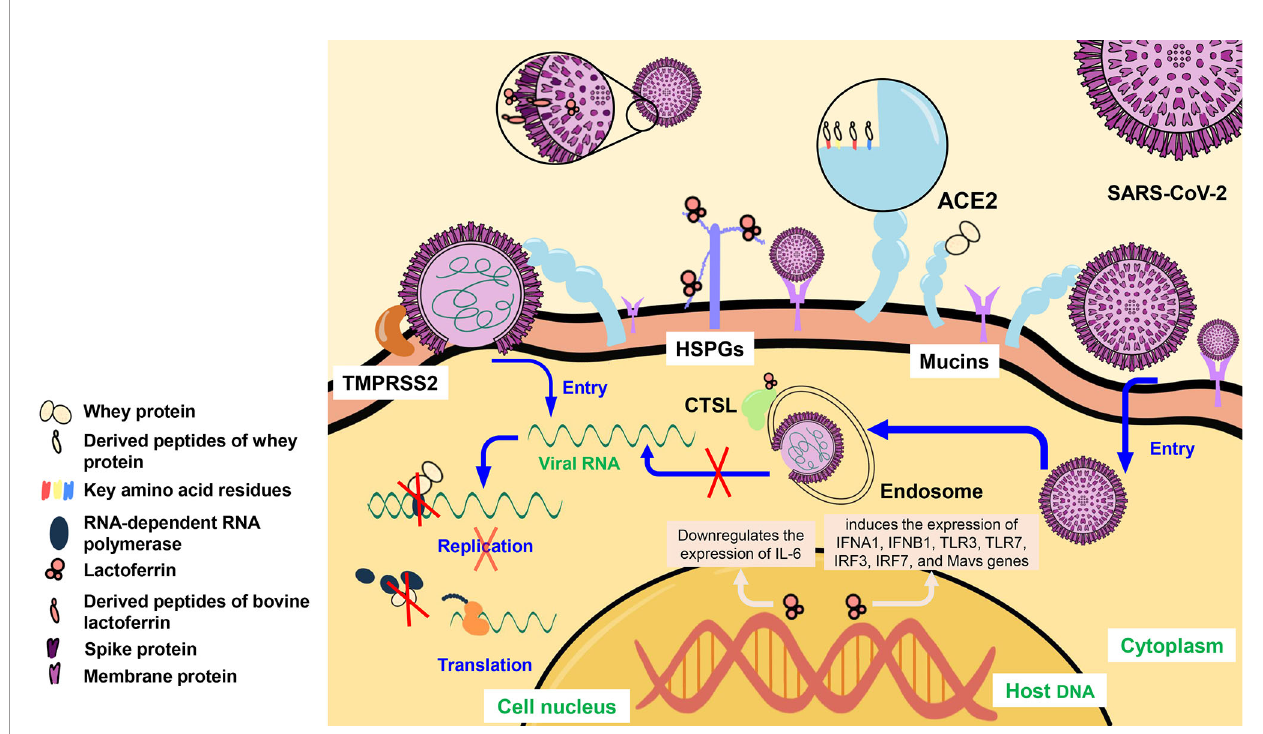
FIGURE 2 | The mechanism of whey protein, lactoferrin, and mucins inhibition of SARS-CoV-2 infection. Whey protein can bind to ACE2 of the host cell and can enter the cell to bind to RdRp, derived peptides of whey protein can bind to key amino acid residues of ACE2. LF can bind to HSPGs and CTSL. Meanwhile, LF can bind to SARS-CoV-2 S proteins and the derived peptide of bLF can bind to SARS-CoV-2 M proteins. In addition, LF entering the host nucleus can induce the expression of IFNA1, IFNB1, TLR3, TLR7, IRF3, IRF7, and MAVS genes, and downregulate the expression of IL-6. Mucins can cover the mucosal cell surface and provide a large number of sialylated residues, and bind to SARS-CoV-2. ACE2, angiotensin-converting enzyme 2; HSPGs, heparan sulfate proteoglycans; TMPRSS2, transmembrane protease serines 2; CTSL, cathepsin L; IL-6, interleukin- 6; IFNA1/IFNB1, interferons A1/B1; TLR3/TLR7, toll-likereceptors 3/7; IRF3/7, interferon regulatory factors